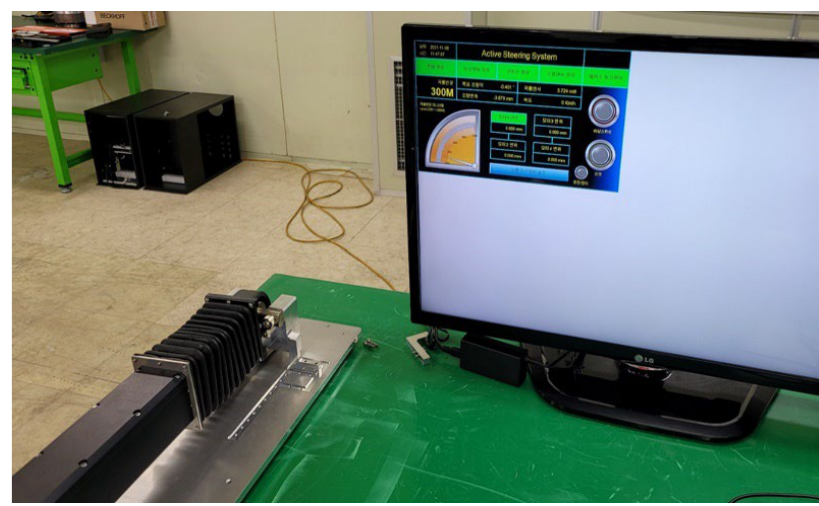
Figure 13. Functional test for curvature sensor.